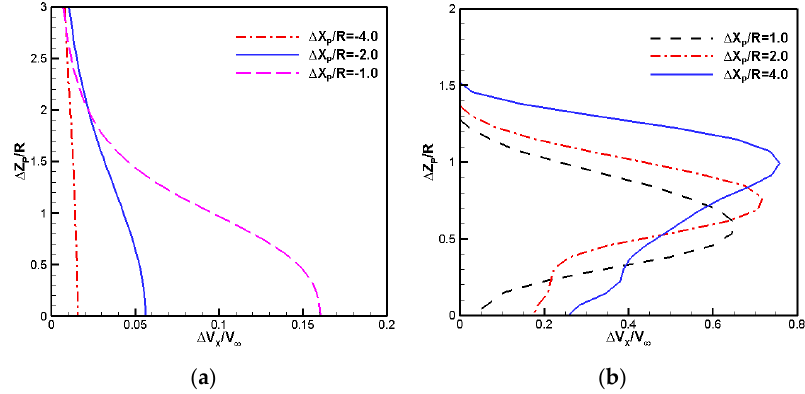
Figure 9. Distributions of the propeller induced velocity for different locations: ( a ) Upstream of the